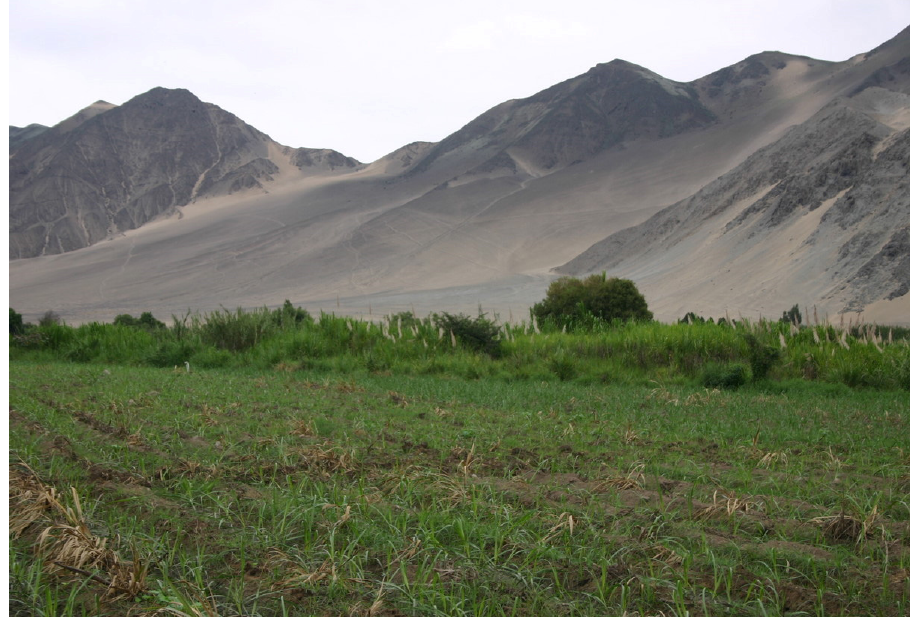
Figure 7. Aeolian sand deposits on the southern side of the Supe Valley produced from aeolian winds from the southern Huara Valley.